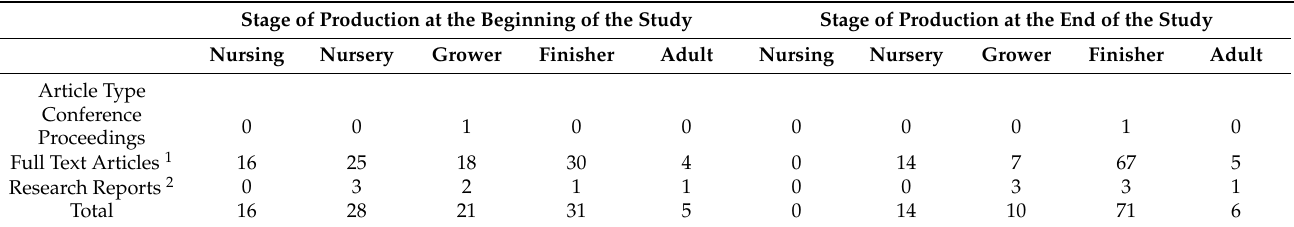
Table 2. Article type and stage of production listed in the article at the beginning of the study and at the conclusion of the study.